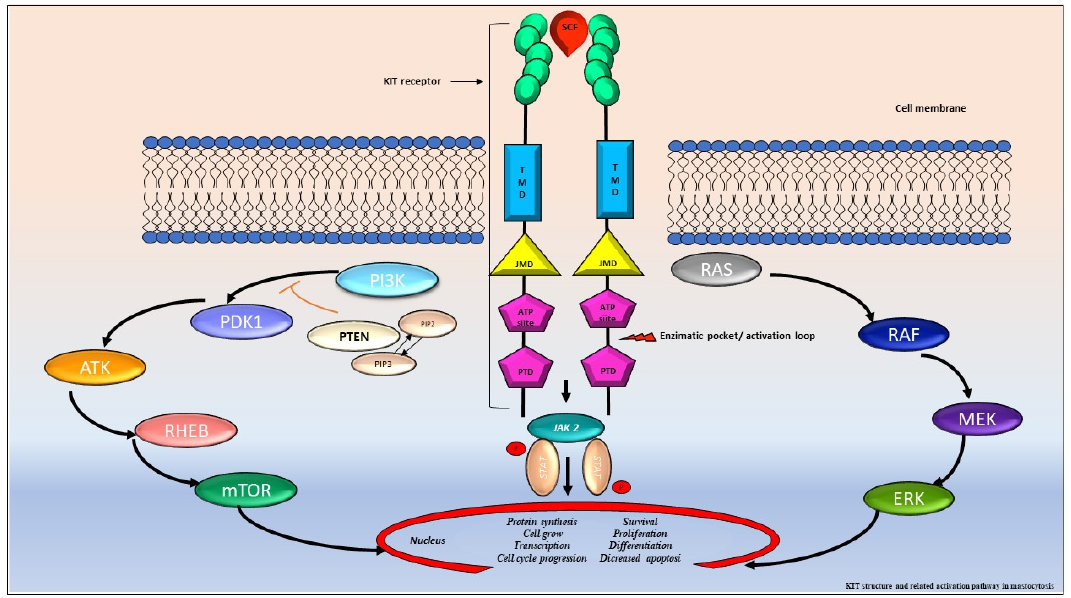
Figure 3. KIT structure and related activation pathway in mastocytosis. The proto-oncogene KIT encodes a type III tyrosine-kinase (TK) receptor, consisting of an extracellular domain (ECD) with five immunoglobulin-like motives, that includes the stem cell factor (SCF) binding site, a transmembrane domain (TMD), a juxta membrane domain (JMD), and two catalytic tyrosine kinase domains with ATP and phosphotransferase domain (PTD) binding site, separated by a kinase insert [42,44]. In normal conditions, the SCF ties the KIT binding site leading to receptor dimerization, autophosphorylation and kinase domain activation. Consequentially, it triggers a cascade of multimolecular phosphorylation resulting in different signal transduction pathways, such as the Janus kinase (JAK) and the signal transducers and activators of transcription (STAT), the phosphatidylinositol triphosphate kinase (PI3K), the rat sarcoma (RAS), and extracellular signal-regulated kinase (ERK) pathway [42,47–49]. In SM, KIT is constitutively activated, resulting in MCs proliferation, differentiation, survival, migration, and cytokine production.